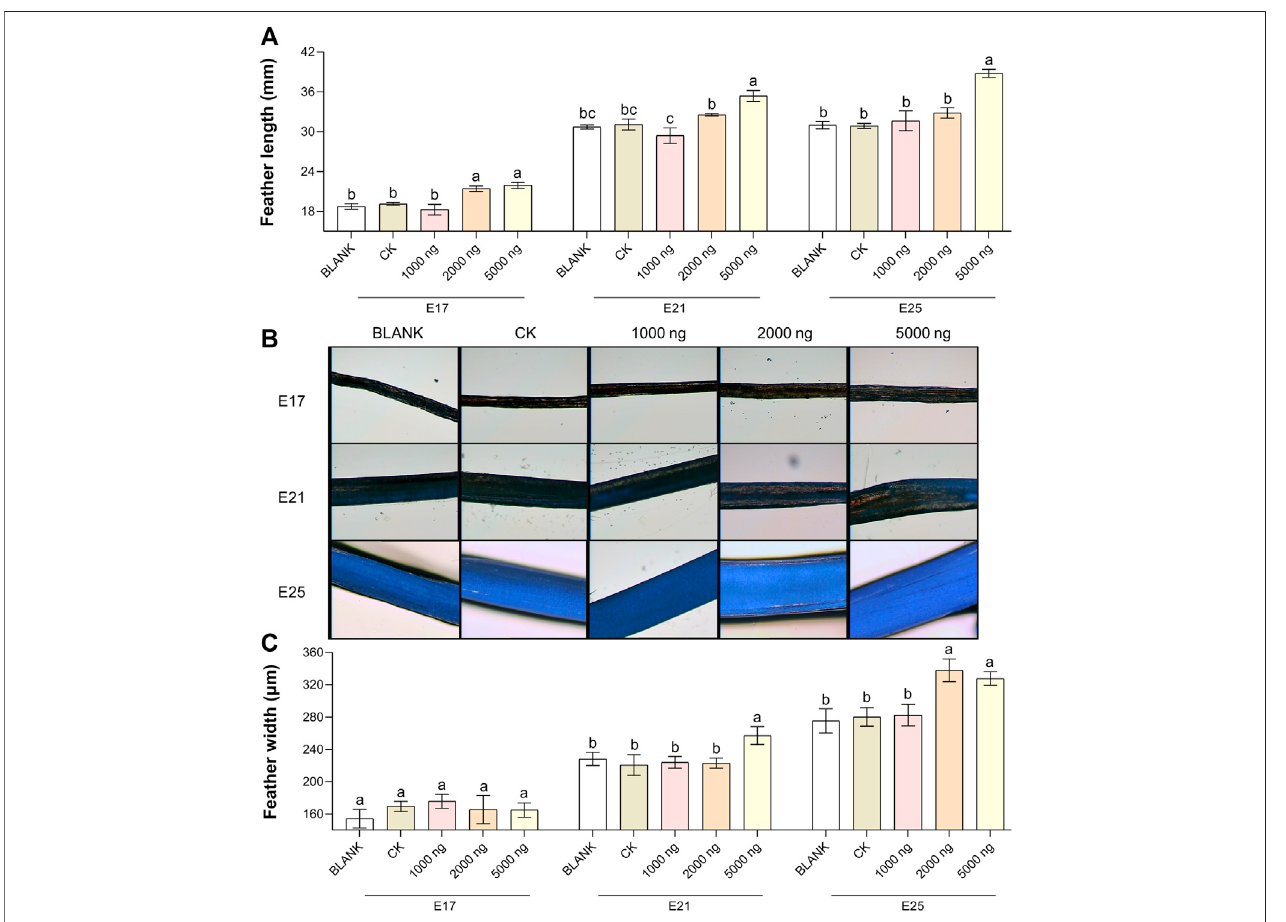
FIGURE2| InovoinjectionofCHIR-99021ingooseembryospromotesfeather growth. (A) FeatherlengthofeachgroupatE17,E21,andE25. (B) Representative images of feather width. (C) Feather width of each group at E17, E21, and E25. All data are shown as mean ± SEM; no common superscript letter within the same embryonic day means statistical difference ( p < 0.05) by one-way ANOVA with Duncan ’ s multiple-range test. n = 6 embryos.